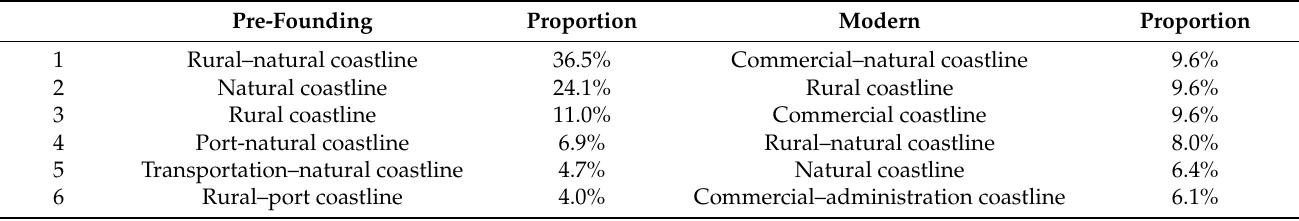
Table 5. Coastline type proportion changes between the pre-founding simulated coastline and the modern simulated coastline in Sanya.